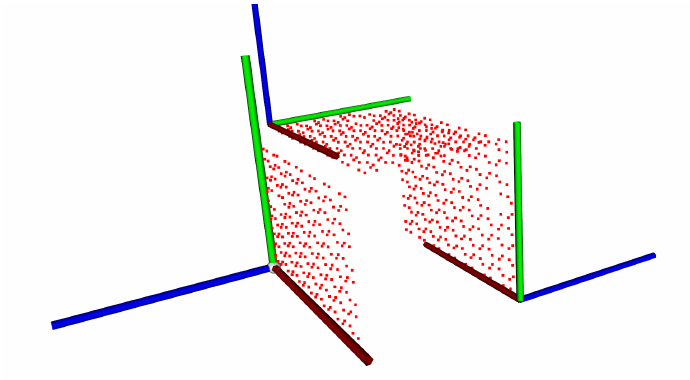
Figure 10. Cuboid with reference points and the coordinate frame of each board.